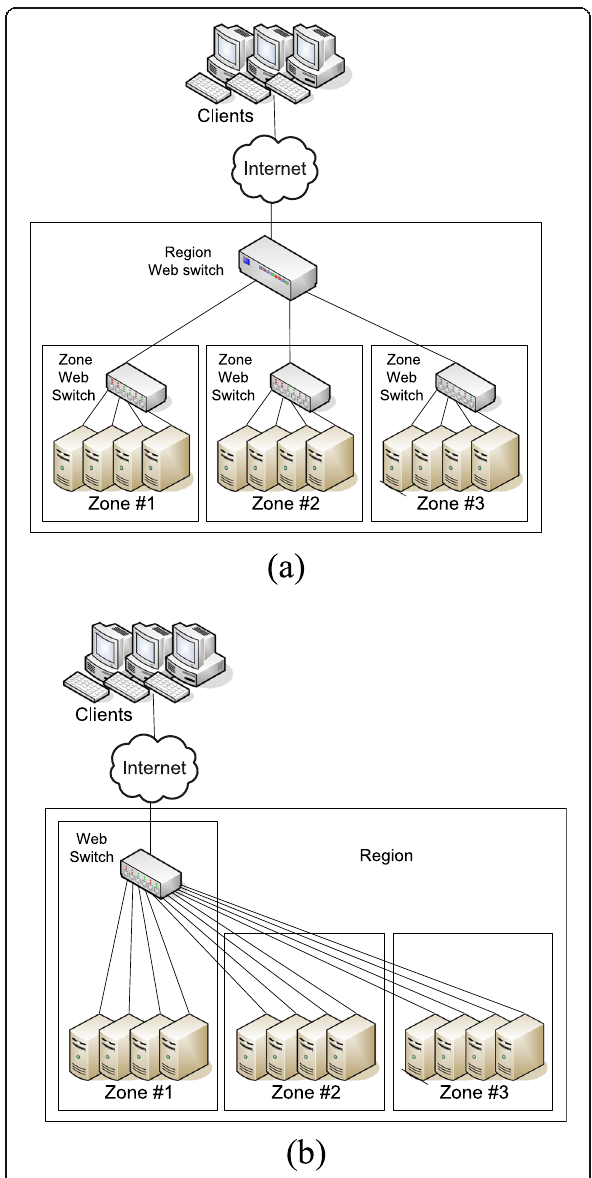
Fig. 2 Decision mechanisms: a one-level decision mechanism, b two-level decision